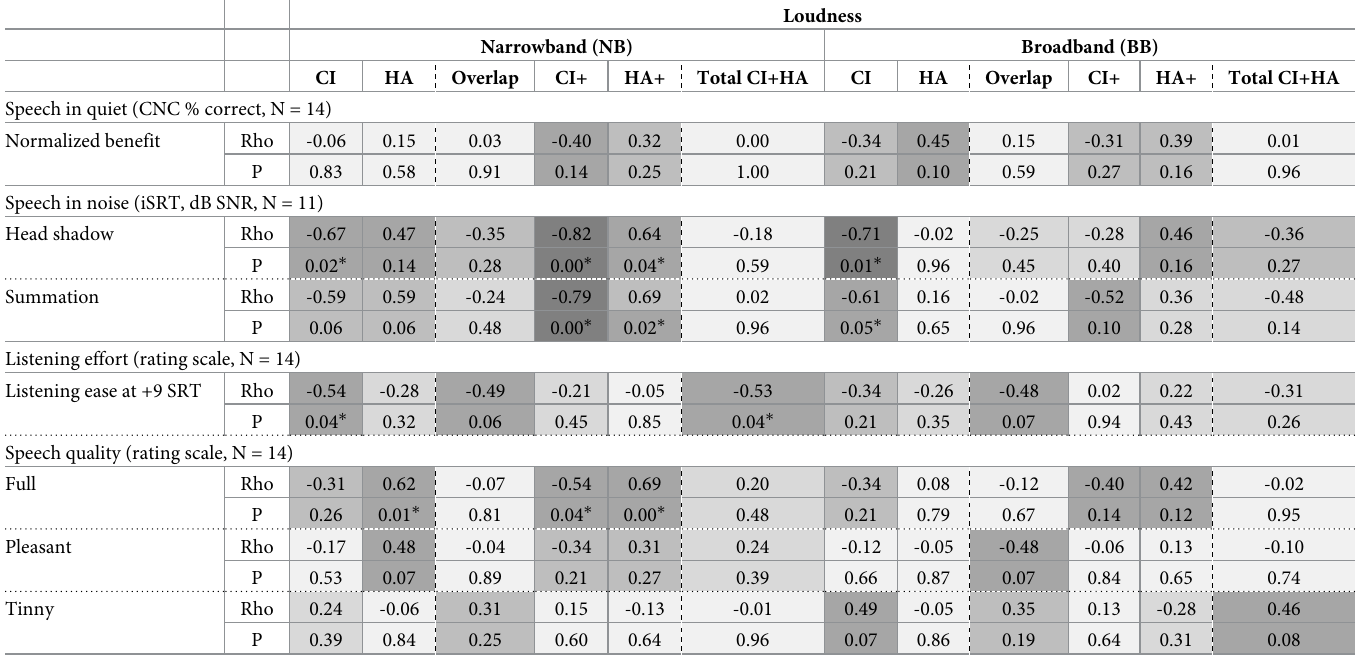
and AUC for ACALOS ) and bimodal benefit on various NB BB